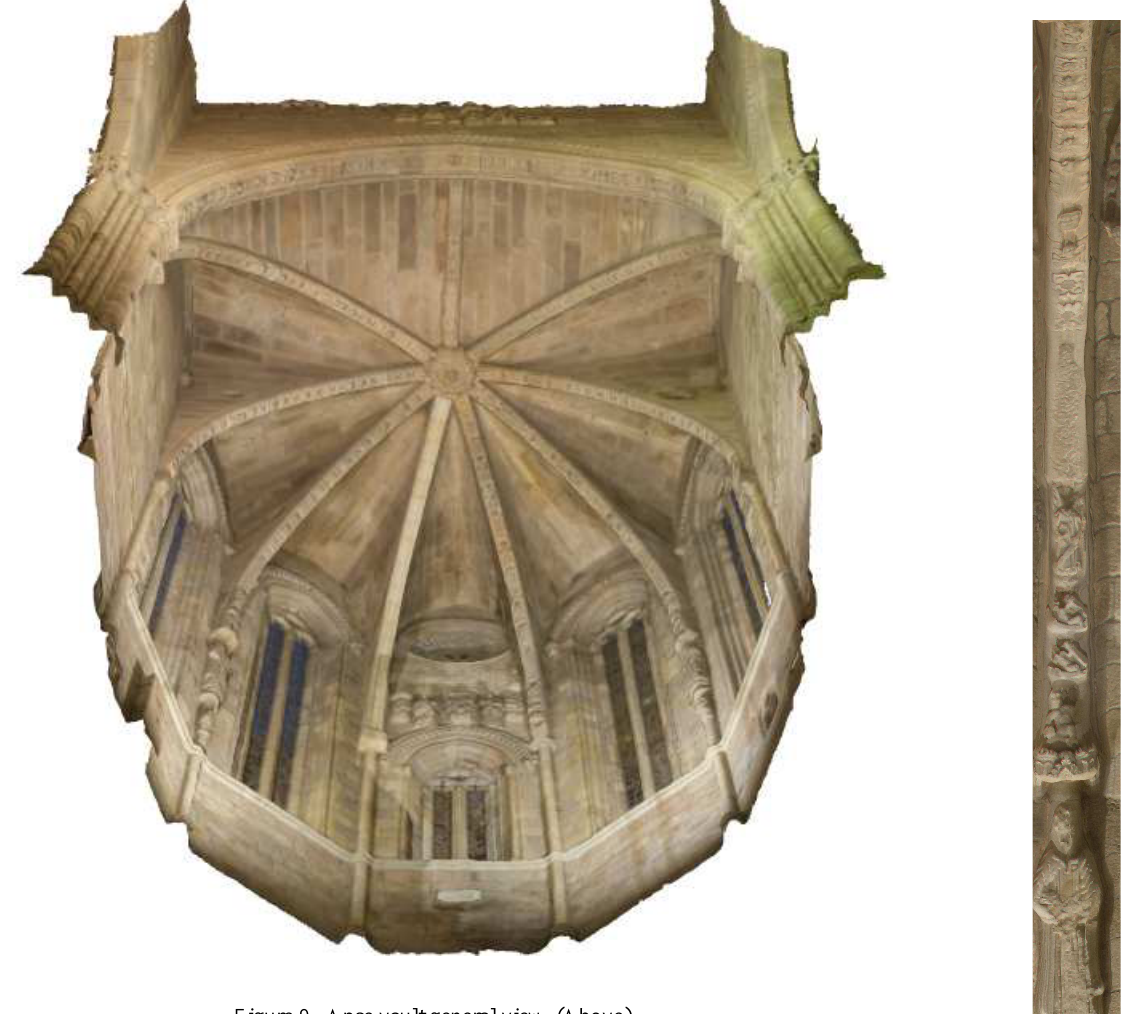
Figure 9. Apse vault general view. (Above) Figure 10. High resolution nerve detail. (Right)